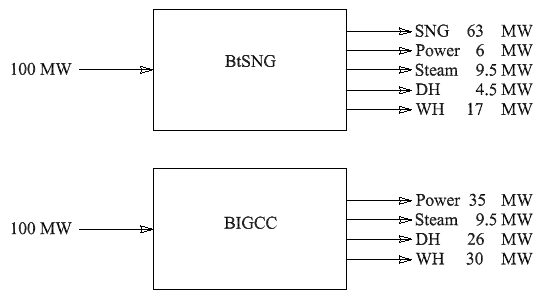
Figure 4. Comparison of BtSNG with BIGCC regarding their outputs in energy content.